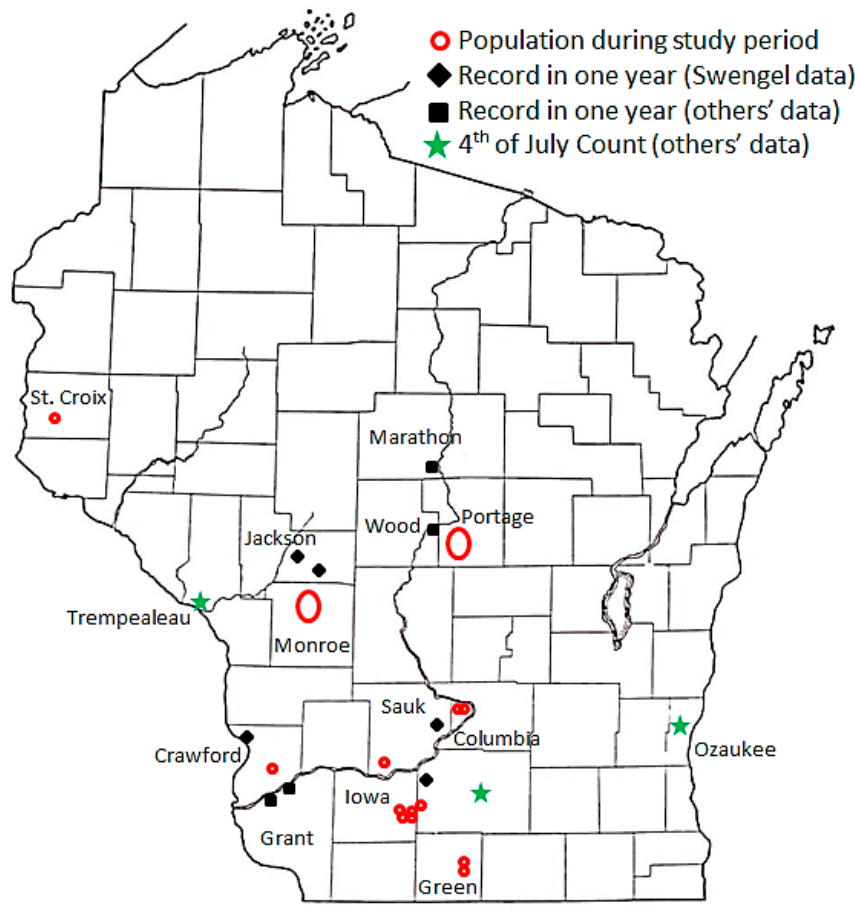
Figure 1. Map of Wisconsin. Counties are identified that contained a Regal fritillary population during the study period (1988–2015) and locations of one-year records on Swengel surveys, others’ observations, and/or a 4th of July Butterfly Count.